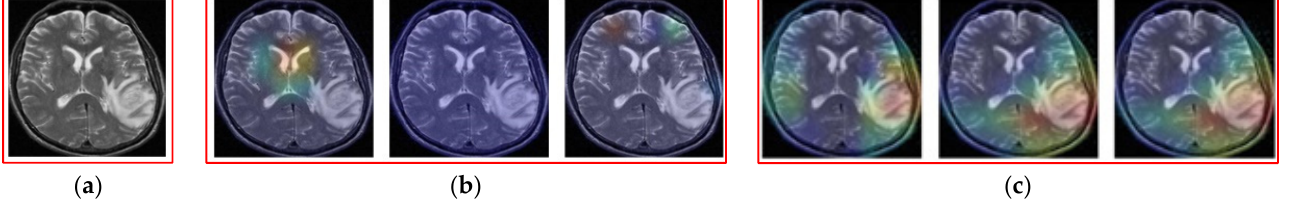
Figure 13. Examples of CAM images using MLP network: ( a ) Input image with tumor lesion (bright region on image), ( b ) CAM image at the last convolution layer of the DenseNet (Left), InceptionNet (Middle), and ResidualNet (Right) with respect to the non-tumor class; and ( c ) CAM images at the last convolution layer of the DenseNet (Left), InceptionNet (Middle), and ResidualNet (Right) with respect to the tumor class.